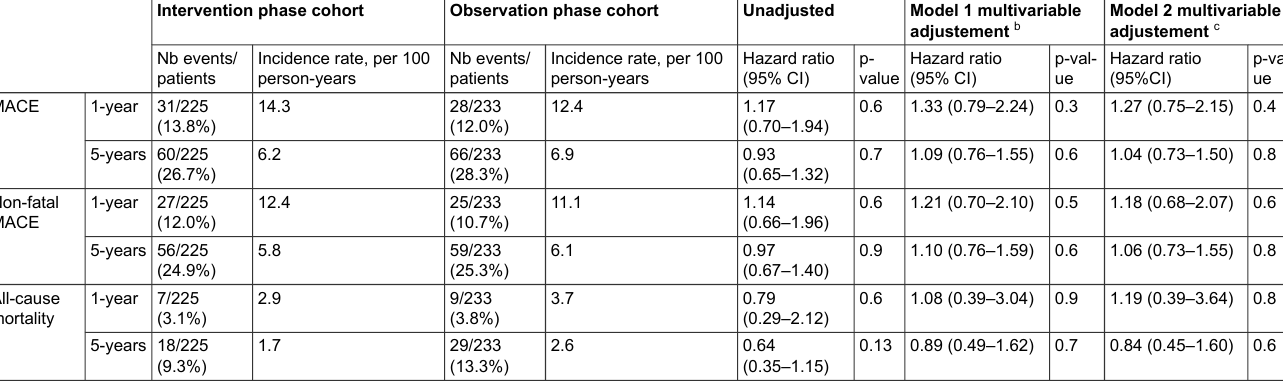
Table 3: Major adverse cardiovascular events (MACE) a and all-cause mortality comparing participants from the intervention phase cohort with the observation phase cohort at 1 year and 5 years after the index ACS using Lambert flexible parametric modelling (n = 458). Intervention phase cohort Observation phase